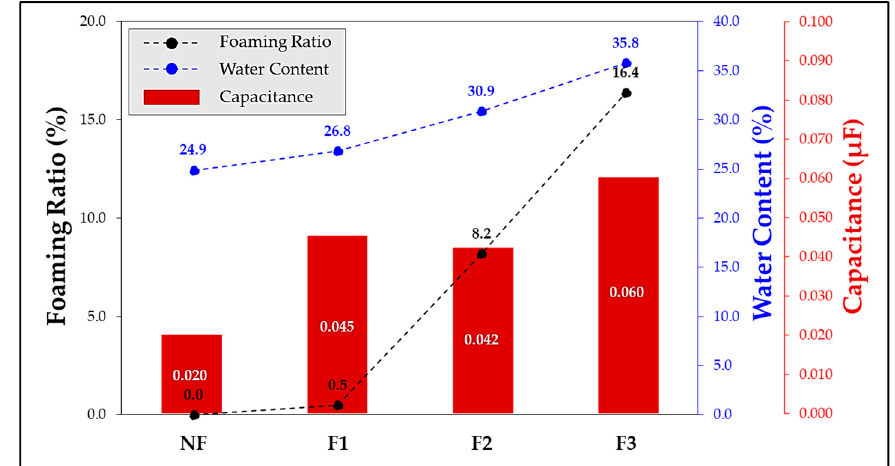
Figure 16. Water content and capacitance corresponding to the foaming ratio of IPMC specimen